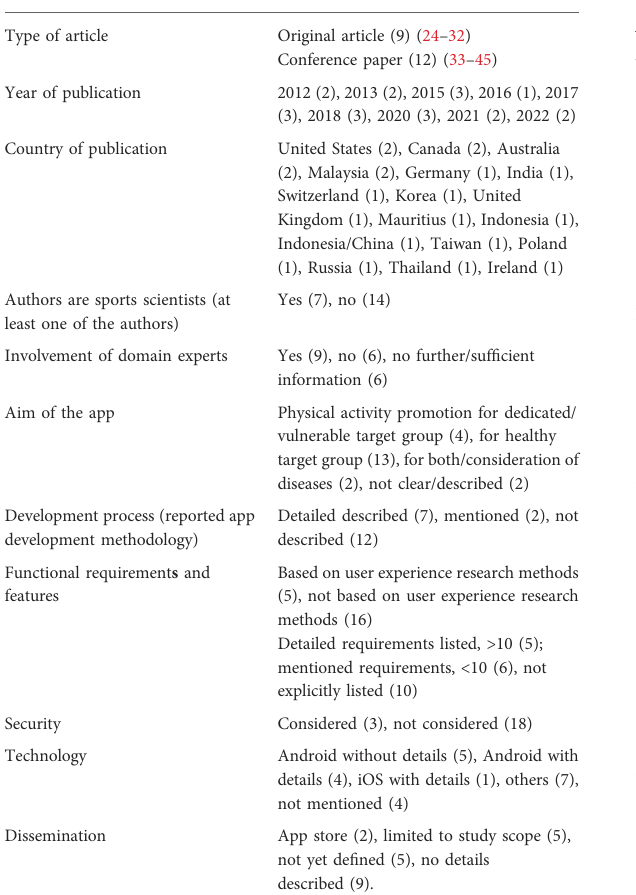
TABLE 1 Findings of the systematic literature review. Outcome Findings ( n )